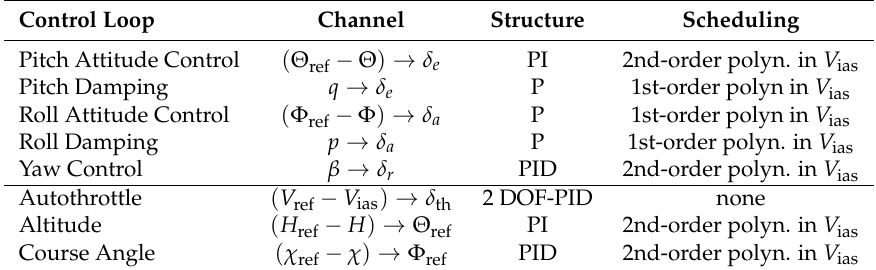
Table 1. Summary of the control loops of the FLEXOP baseline flight control system with the inner loop functions (first part) and autopilot functions (second